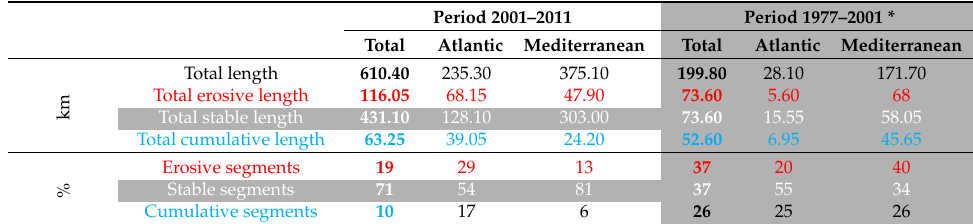
Table 3. Erosion (red), stable (white), and accumulation rates statistics (blue) for the most recent time period (2001–2011), and * denotes the time period between 1977 and 2001. The beaches assessed in this period (gray background) were urban beaches or beaches associated with coastal infrastructures that showed a stable tendency in the most recent